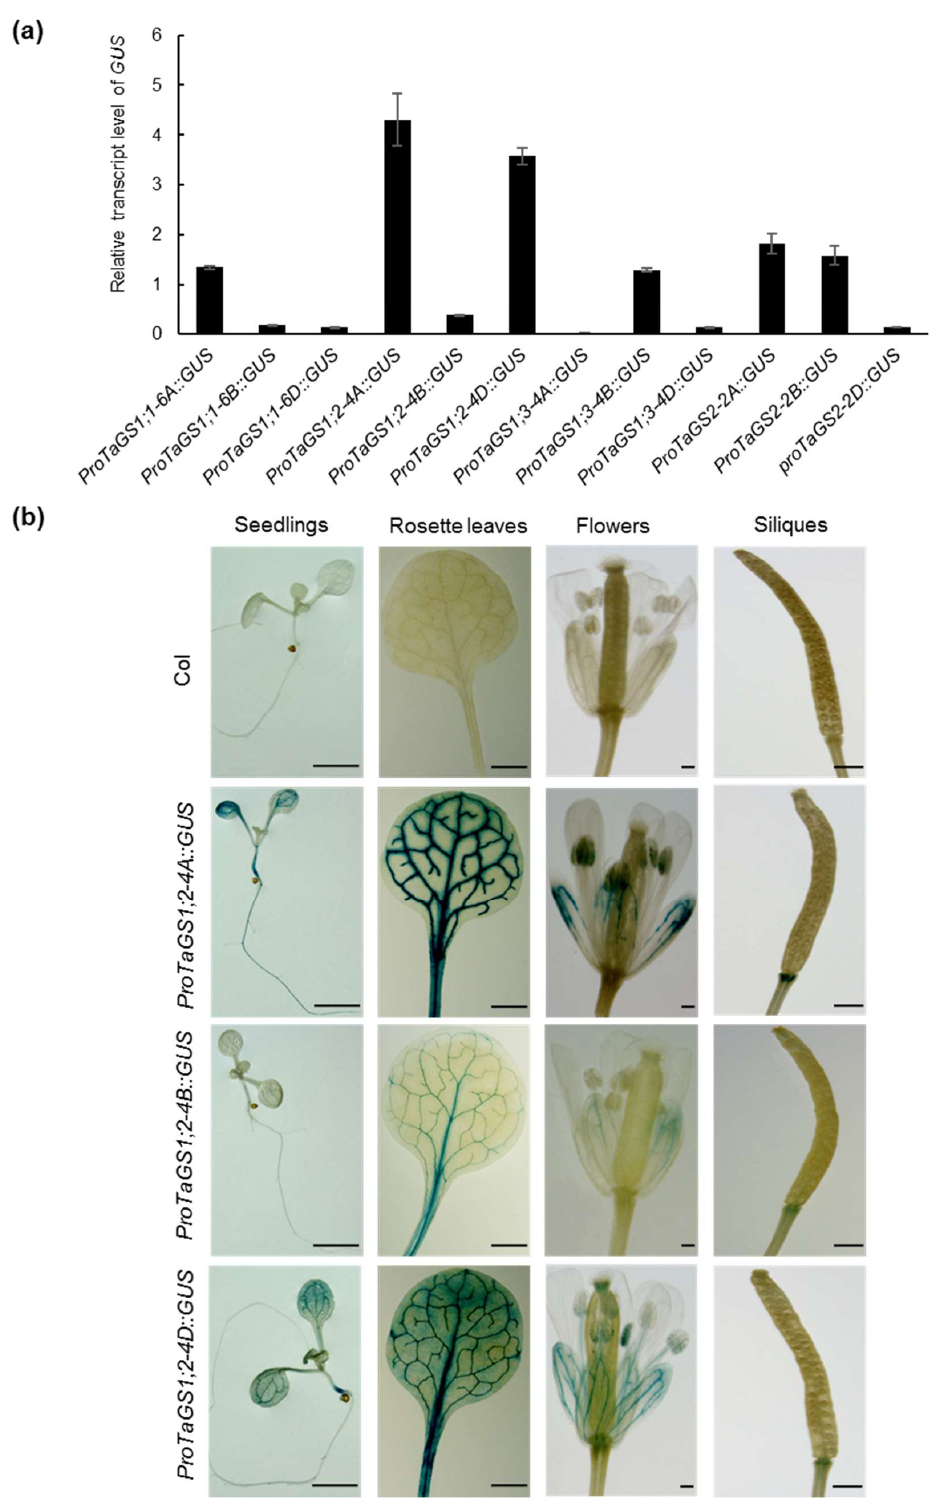
Figure 2. Patterns of GUS expression driven by the promoters of the TaGS genes in Arabidopsis . Transgenic lines were transformed with transcriptional fusions between the TaGS gene promoter and the GUS reporter gene. ( a ) qRT-PCR analysis of GUS expression in transgenic lines. Gene expression levels were normalized to reference gene AtUBQ11 . Data are means of three independent biological replicates ± SD. ( b ) GUS staining was observed in 10 d old seedlings, rosettes leaves of 25 d old plants, and flowers and siliques of 40 d old plants. The blue signal indicates GUS activity. Scale bars are 1 mm.